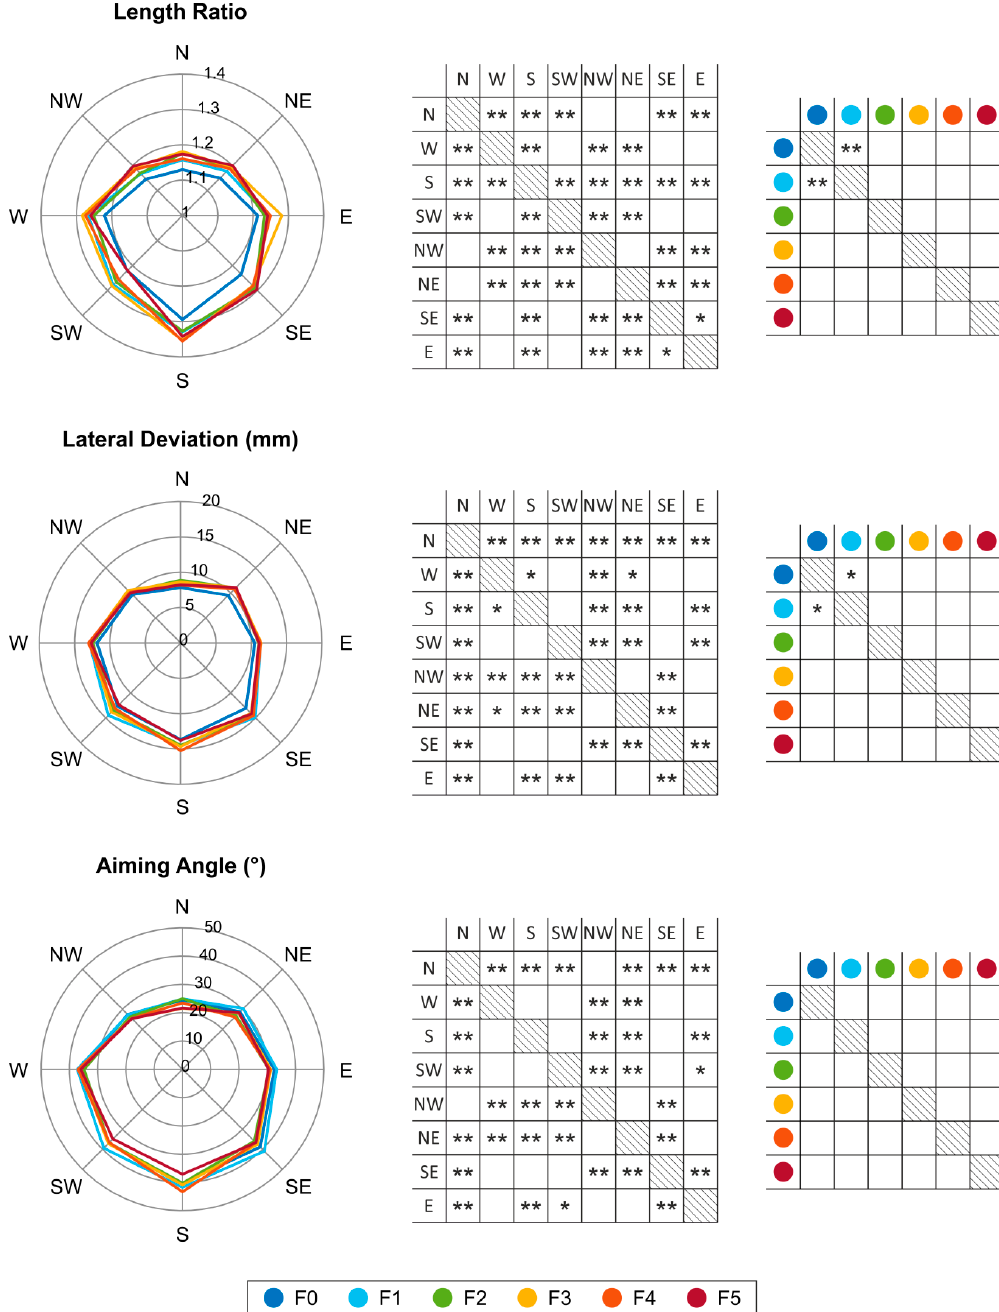
Figure 4. Speed Metric (SM) and Normalized Jerk (NJ): mean values among subjects and repetition for each force and each direction on the left; the interaction factor was significant and on the right the one-way ANOVA results: differences between the direction and between the force. (‘*’ represents p -value <0.05; ‘**’ represents for p -value <0.01).